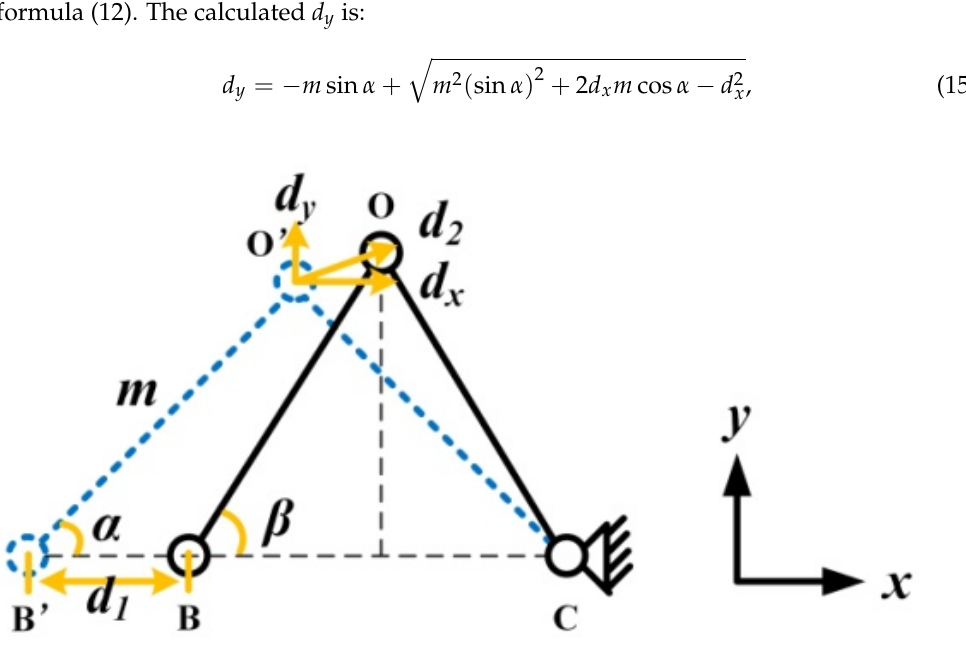
Figure 9. Simplified model of the triangular amplification structure.